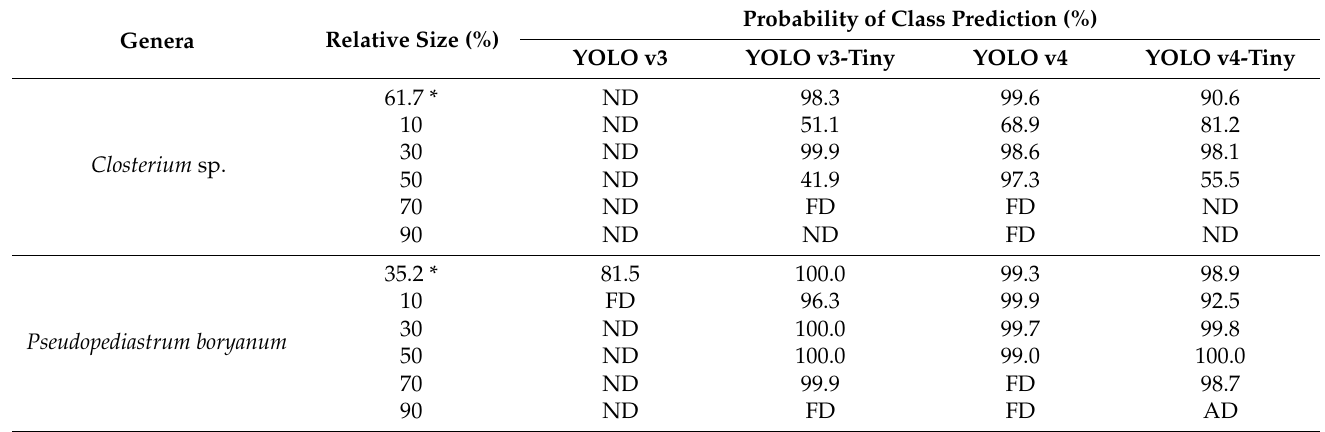
Table 6. The performance comparison of YOLO models for various relative object sizes.